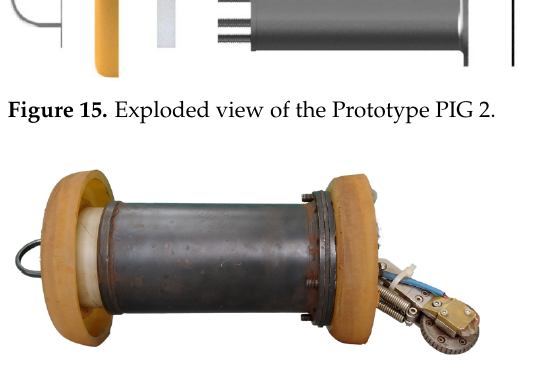
Figure 16. Prototype PIG 2 (side view picture).